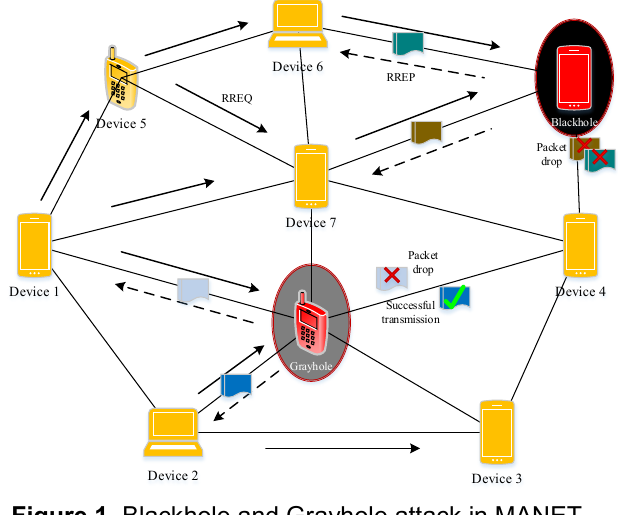
Figure 1. Blackhole and Grayhole attack in MANET-